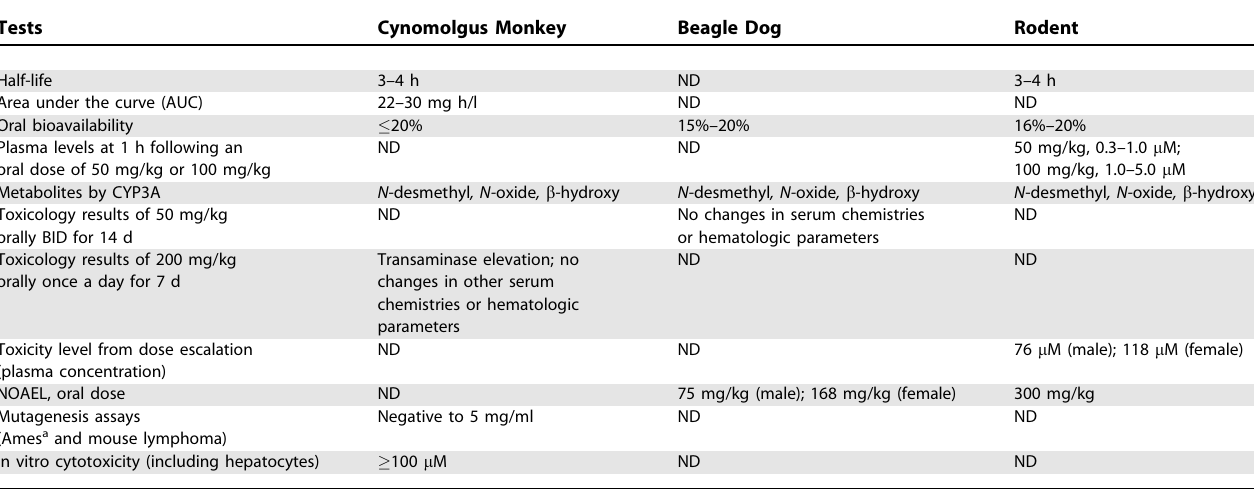
Table 1. Summary of ADME and Toxicology of